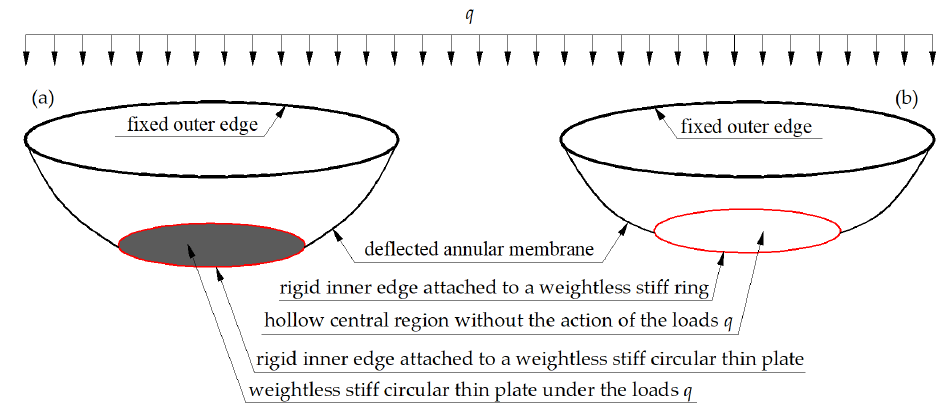
Figure 1. Two types of transversely and uniformly loaded annular membrane structures. ( a ) Alekseev-type annular membrane structure, where the inner edge is attached to a weightless stiff circular thin plate; ( b ) Sun-type annular membrane structure, where the inner edge is attached to a weightless stiff ring, resulting in a hollow central region without the action of the load q .